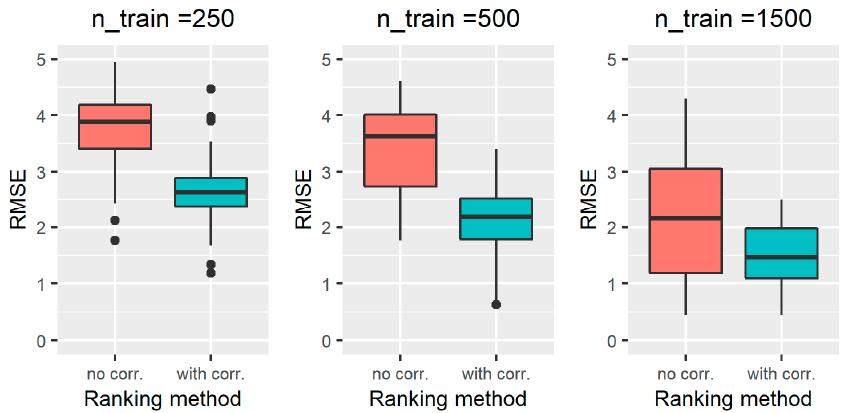
Figure 4. RMSE results obtained for the standard RFE-Borda count method (red boxplot, “no corr.” label) and the proposed algorithm (green boxplot, “with corr.” label) for scenarios 7–9, characterized by a number of training samples equal to 250 ( left ), 500 ( middle ), and 1500 ( right ).